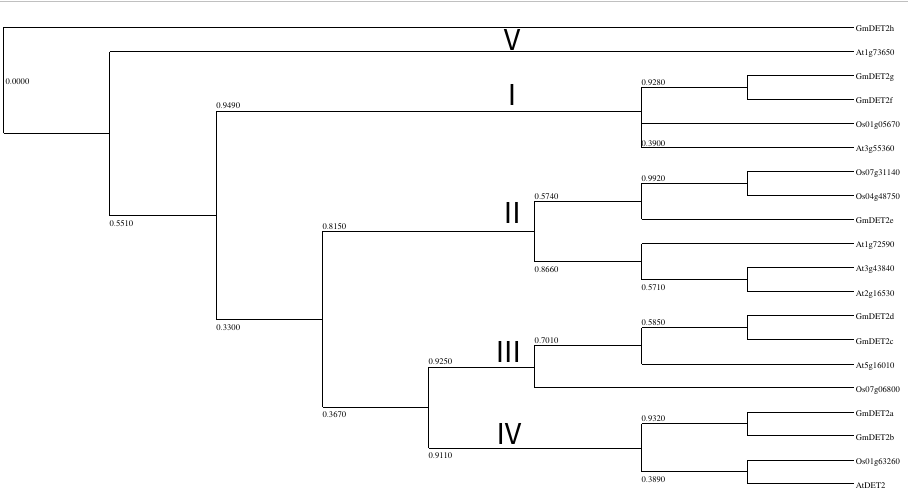
Figure 2. Molecular Phylogenetic analysis by the maximum likelihood method. The evolutionary history was inferred by using the maximum likelihood method based on Jones et al.’s w/freq. model [44]. The tree with the highest log likelihood ( − 2073.6839) is shown. The percentage of trees in which the associated taxa clustered together is shown next to the branches. Initial tree(s) for the heuristic search were obtained automatically by applying the neighbor-join and BioNJalgorithms to a matrix of pairwise distances estimated using a JTTmodel and then selecting the topology with the superior log likelihood value. A discrete gamma distribution was used to model evolutionary rate differences among sites (five categories (+G, parameter = 5.1876)). The tree is drawn to scale, with branch lengths measured in the number of substitutions per site. The analysis involved 20 amino acid sequences. All positions containing gaps and missing data were eliminated. There was a total of 74 positions in the final dataset. Evolutionary analyses were conducted in MEGA6 [42]. Steroid reductases from soybean, Arabidopsis and rice can be grouped into five subgroups (I, II, III, IV and V). To identify the selection pressure during evolution of plant steroid reductases, we explored the ratios of Ka to Ks (Ka/Ks) of steroid reductase from P. patens , S. moellendorffii , O. sativa , B. distachyon , G. max and A. thaliana . Generally, genes are subjected to three kinds of selection, namely positive selection (Ka/Ks > 1), neutral selection (Ka/Ks = 1), and negative or purifying selection (Ka/Ks < 1). Results in Figure 4 showed that plant steroid reductase are subjected to purifying selection, except for three branches marked in red, in which the Ka/Ks are greater than one (Figure